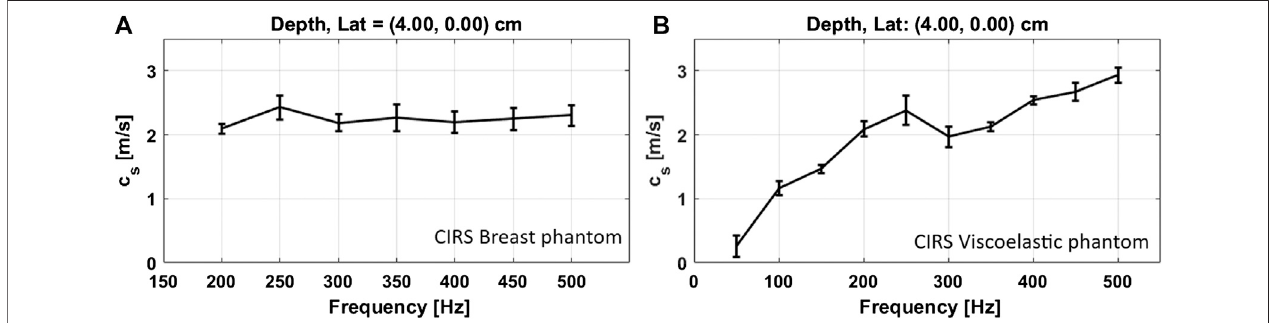
FIGURE 5 | Phase velocity dispersion curves. Estimated SWS vs. frequency plots for the CIRS breast (A) and viscoelastic phantoms (B) . The center depth and lateral positions of a selected region of interest, to extract the SWS values, are indicated above each plot. As expected, a higher dispersion was obtained for the viscoelastic media. ©Institute of Physics and Engineering in Medicine. Reproduced from Ref. 15 by permission of IOP Publishing. All rights reserved.